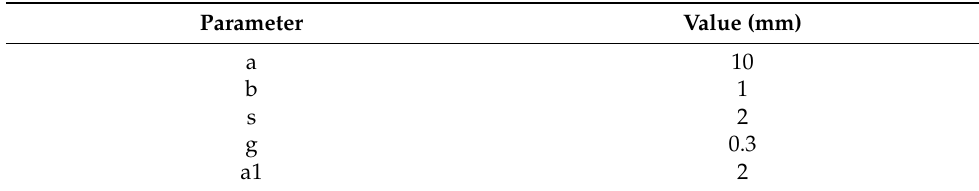
Figure 4. Simulated magnitude electric field distributions of CSRR-based pressure sensor.